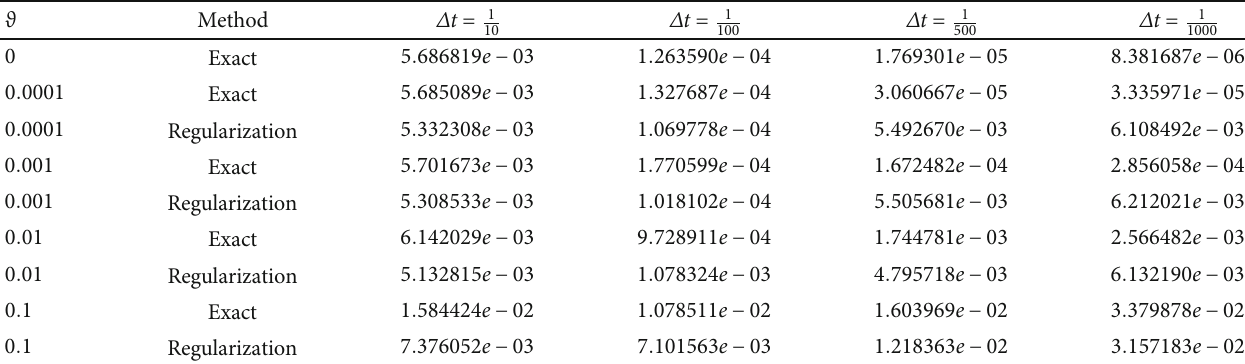
Figure 8: The exact solution (left) and the absolute error (right) of Example 4 with Δ t = 0 : 001 and h = 0 : 01 , without noise. ff erent values of Δ t and ϑ with h = 0 : 05 Table 4: L ∞ errors of Example 4 for di